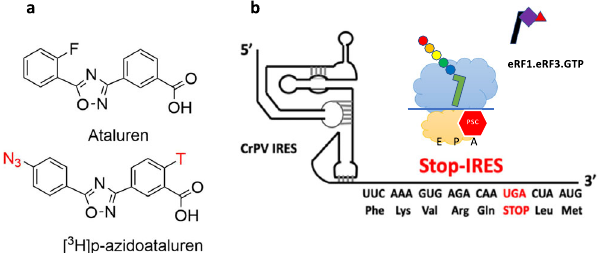
Fig. 1 Targets of azidoataluren photoincorporation. a Structures of ataluren and [ 3 H]-AzAt. T refers to tritium. N 3 is the azide which confers photolability on azidoataluren. b Stop-IRES mRNA encoding FKVRQStopLM. The cartoon depicts the Stop-POST5 complex containing FKVRQ-tRNA Gln bound in the P-site adjacent to an empty A-site containing the UGA stop codon, and the incoming eRF1.eRF3.GTP complex which catalyzes cleavage of the ester bond linking FKVRQ to tRNA Gln after binding to the